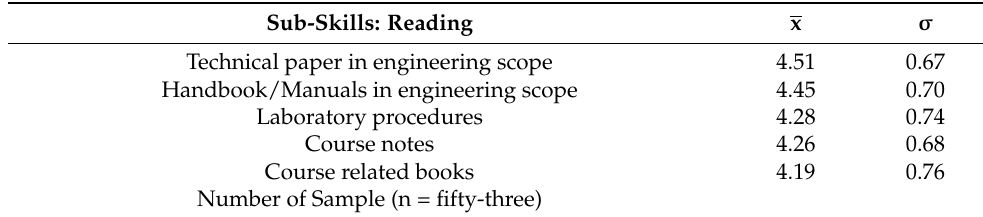
Table 4. The Significance in the Enhancement of Reading